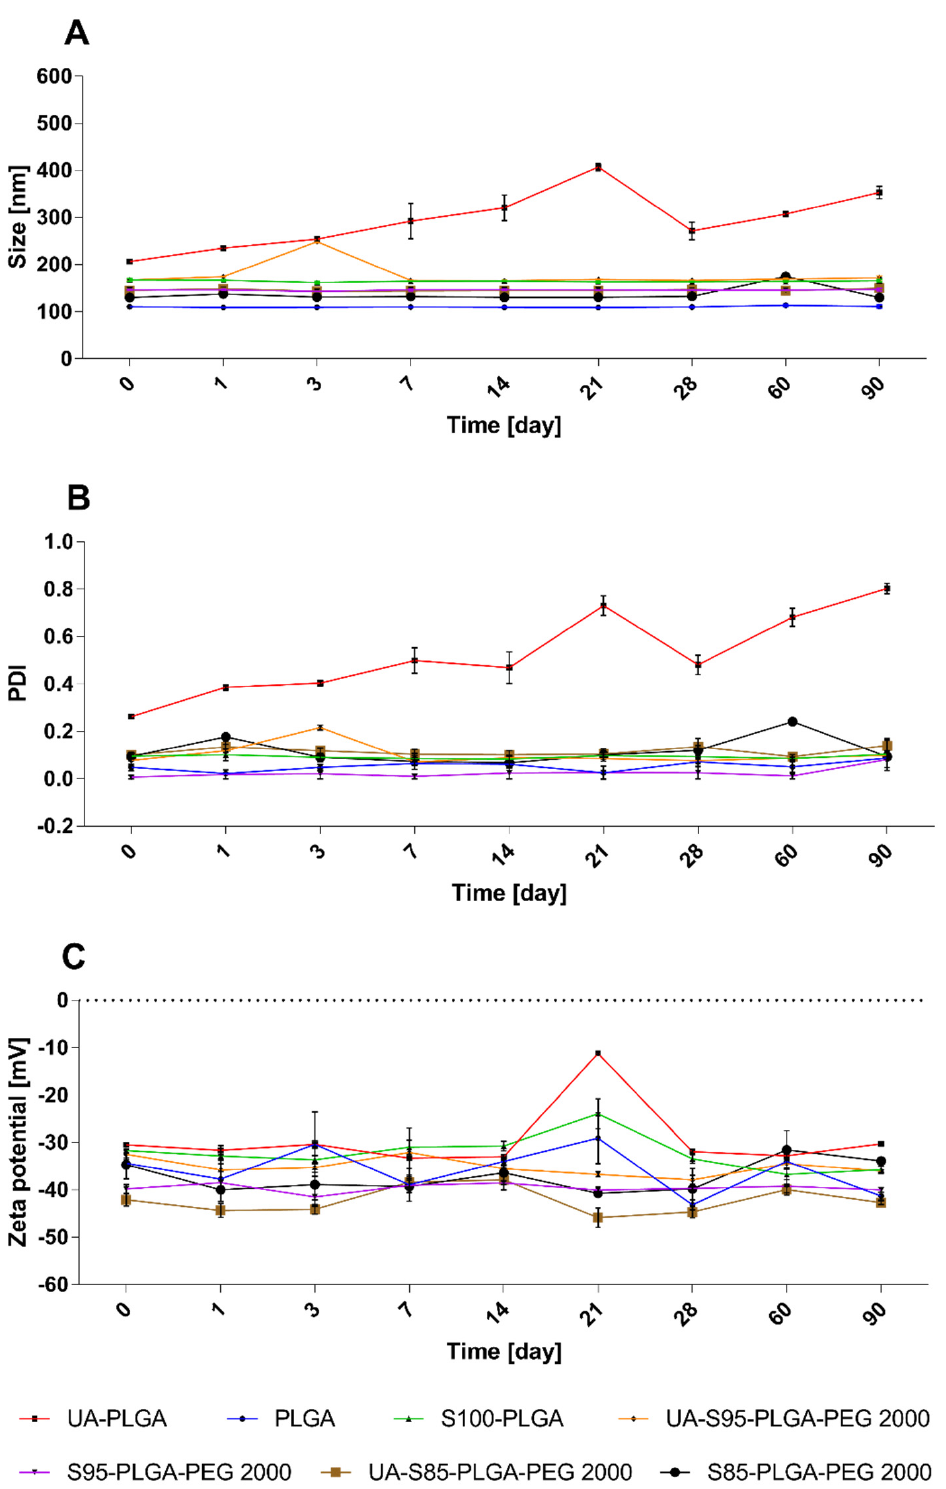
Figure 4. Stability of different bare and coated, non-loaded and loaded nanoparticles: changes in size graph ( A ), PDI graph ( B ), and zeta potential graph ( C ) values.